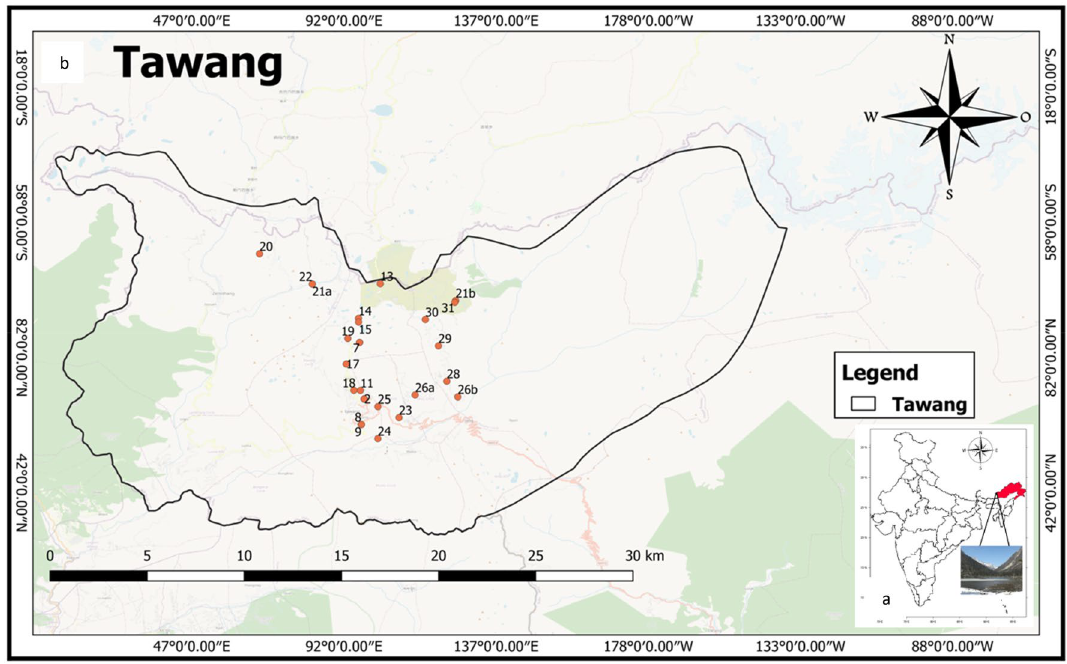
Figure 1. Location Map of Ecological hotspot of Tawang, Arunachal Pradesh, India. ( a ) Location of Tawang on Indian map ( b ) Sample collection sites. QGIS Software Desktop 3.18.3 (https:// qgis. org/ en/ site/ forus ers/ downl oad.